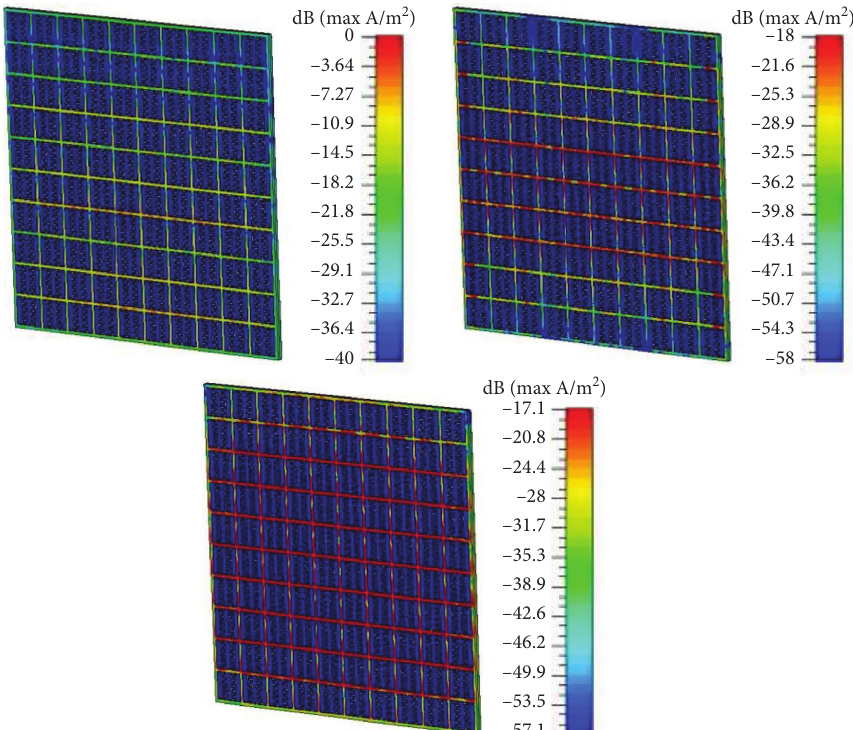
Figure 11: The current density simulation results of 10 × 10 ICPW-EBG array at 1.8GHz, 2.45GHz, and 3.7GHz, respectively.